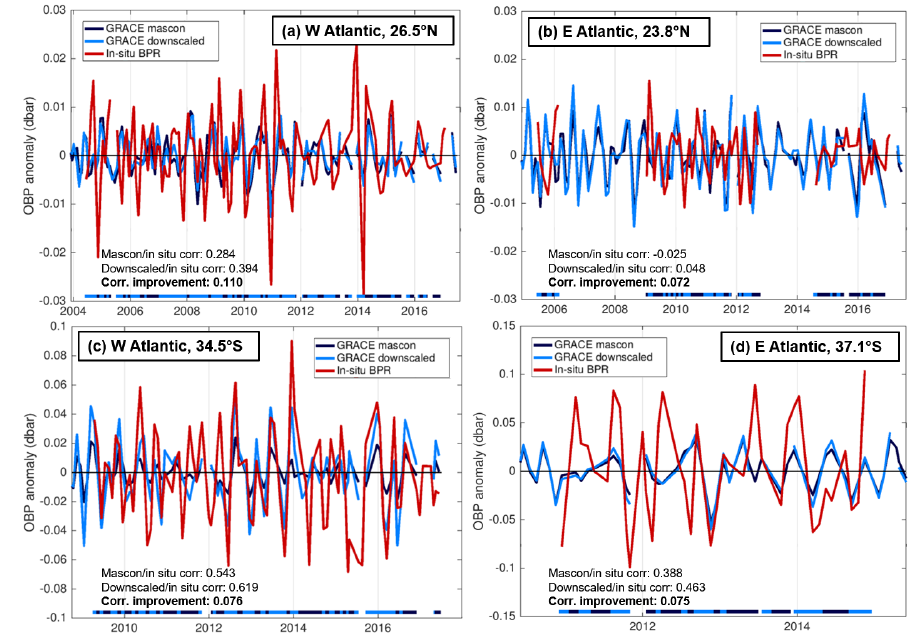
Figure 6. Time series comparisons of in situ BPR time series with (non-downscaled) GRACE mascon OBP and downscaled GRACE OBP, filtered for 3–12 month timescales with temporal mean, trend, and seasonal cycle removed. The horizontal bars at the bottom of each plot (dark blue or light blue) indicate whether the absolute difference of | non-downscaled − in situ | (dark blue) or | downscaled − in situ | (light blue) is smaller. Locations of each site are ( a ) 26.51 ◦ N, 76.74 ◦ W, 3700 m depth, ( b ) 23.8 ◦